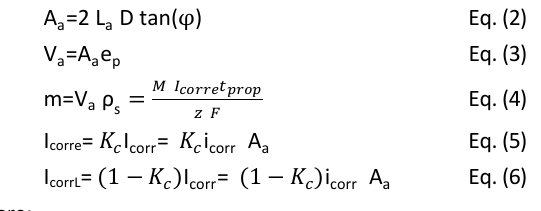
Figure 15 proposed a geometry of the corrosion pit based on